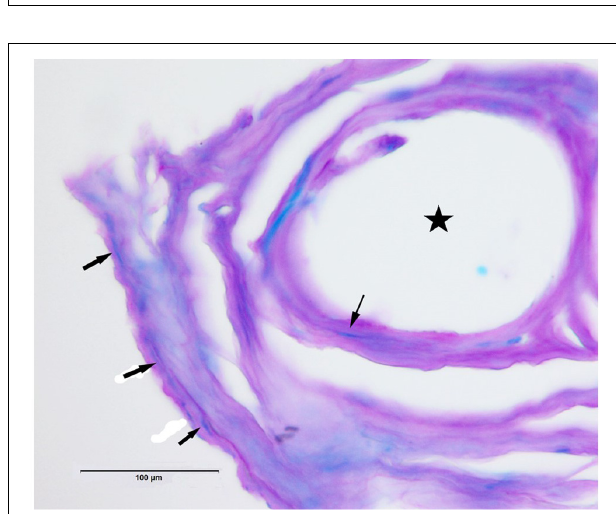
FIGURE 7 | This Panel illustrate the stained neurofilaments indicated by arrows. The black star indicates the opening for the electrode wire. Magnification is × 40.